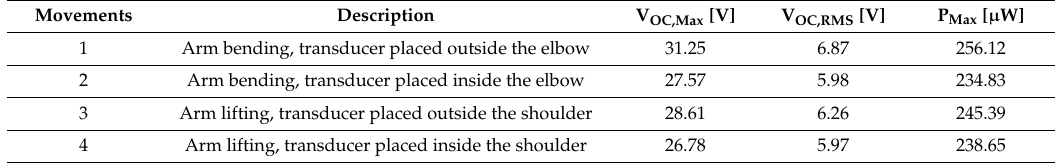
characterized piezoelectric harvesters for di ff erent joint movements repeated at 1 Hz